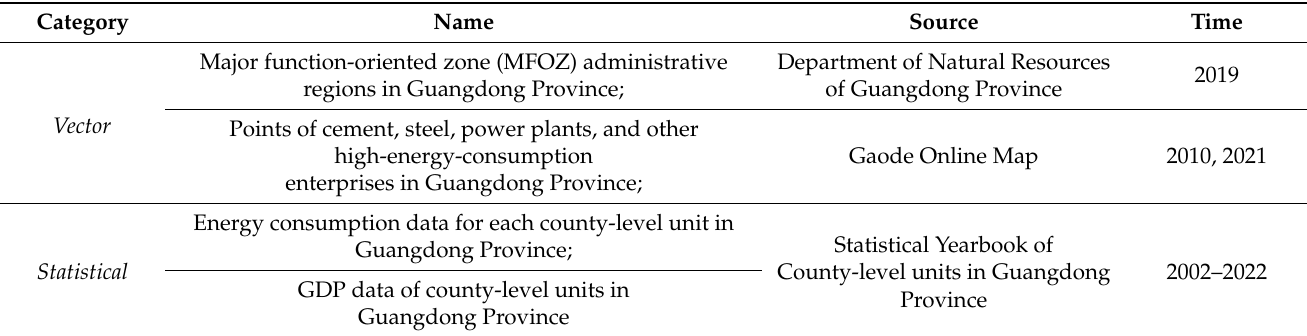
Table 2. Data sources used in this study.